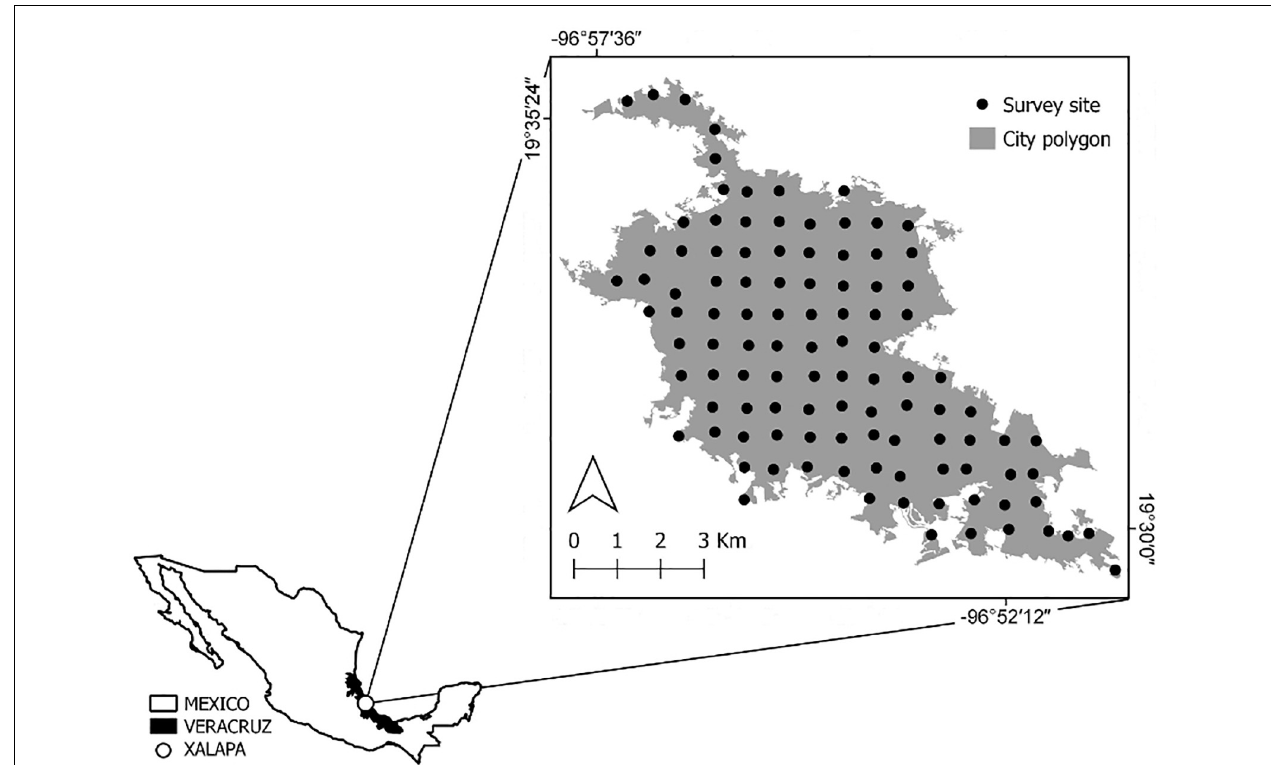
FIGURE 1 | Location of sampling sites within the urban continuum of the city of Xalapa using a citywide grid of 750 m × 750 m. Dots represent survey